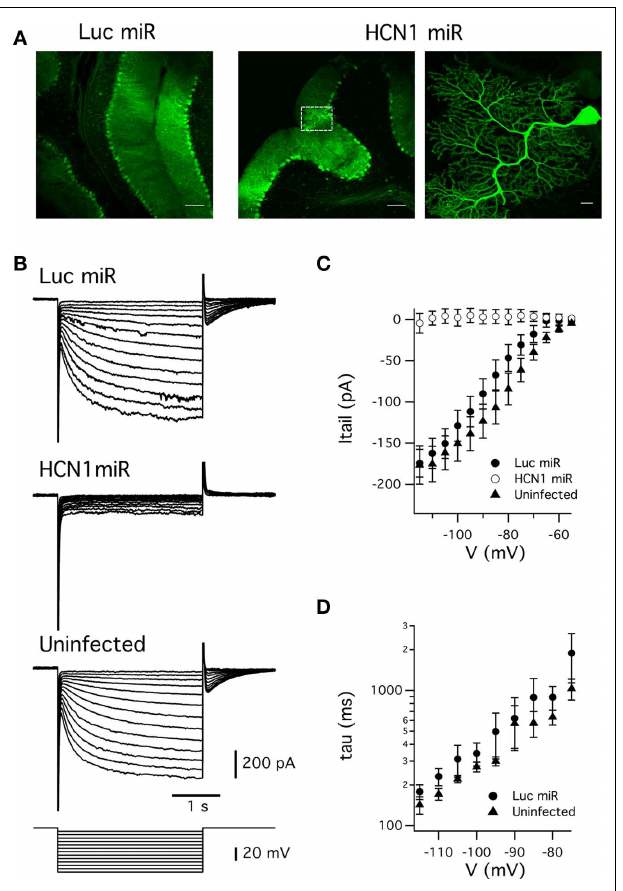
FIGURE 5 | Expression of miRNAs targeted against HCN1 abolishes hyperpolarization-activated currents recorded from cerebellar Purkinje cells. (A) Native fluorescence of EGFP from cerebellar Purkinje cells transduced with AAVs expressing miRNAs targeting either luciferase (Luc miRNA) or HCN1 (HCN1 miR).The higher magnification image (right panel) corresponds to an HCN1miR expressing cell indicated by the white box (middle panel). Scale bars = 100 μ m in left and middle panels, 10 μ m in right panel. (B) Membrane current responses (upper three panels) to hyperpolarizing voltage steps (lower panel) recorded from a Purkinje cell infected with AAV expressing Luc miR (top), HCN1 miR (upper middle) or uninfected (lower middle). (C) Mean I h tail current amplitude plotted as a function of test potential for each group of Purkinje cells.Tail current amplitudes differed between groups at membrane potentials ≤− 65mV ( p < 0.05, ANOVA).There was no significant difference between tail currents from Luc miR infected and uninfected neurons at any test potential ( p > 0.05, unpaired Student’s t -test), whereas tail currents from cells infected with HCN1 miR differed from the Luc miR group at potentials ≤− 75mV and from the uninfected group at all test potentials ( p < 0.05, unpaired Student’s t -test). (D) Activation time constant plotted as a function of test potential for I h recorded from uninfected Purkinje cells and from Purkinje cells infected with Luc miR.The time constant did not differ significantly between uninfected and Luc miR infected Purkinje cells at any test potential ( p > 0.05, unpaired Student’s t -test). Group sizes for voltage-clamp experiments were as follows: Luc miR ( n = 6 cells, 3 mice); HCN1 miR ( n = 6 cells, 3 mice); uninfected ( n = 6 cells, 4 mice).